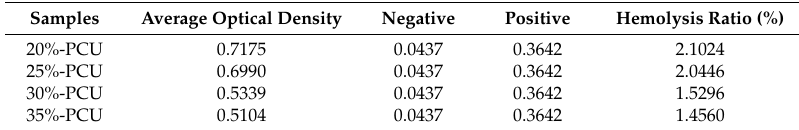
Table 3. Hematolysis ratio of all types of membranes.